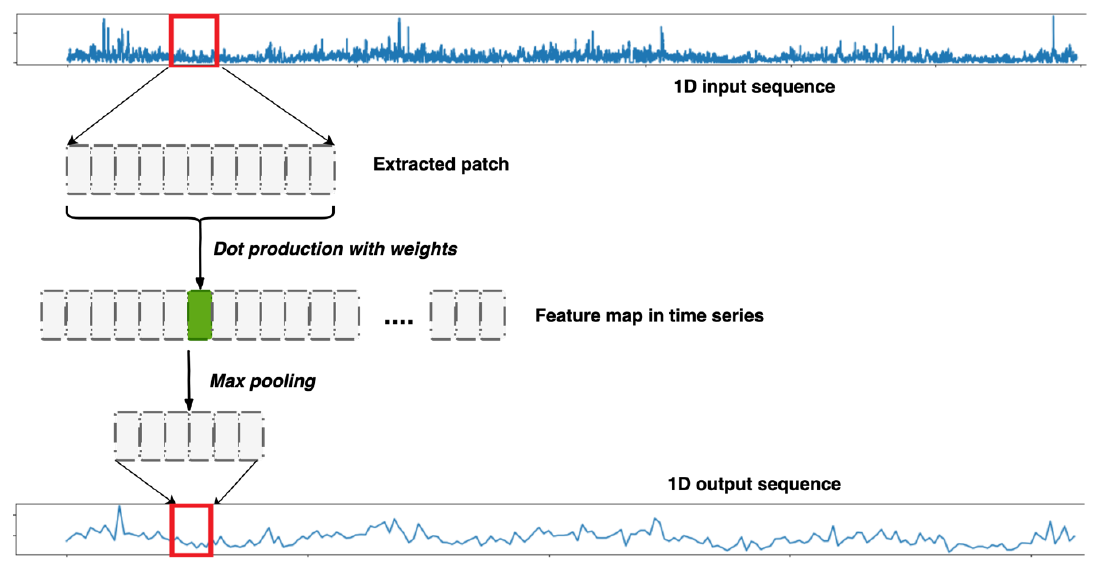
Figure 5. Time-sequence processing by a one-dimensional (1D) convolutional layer.